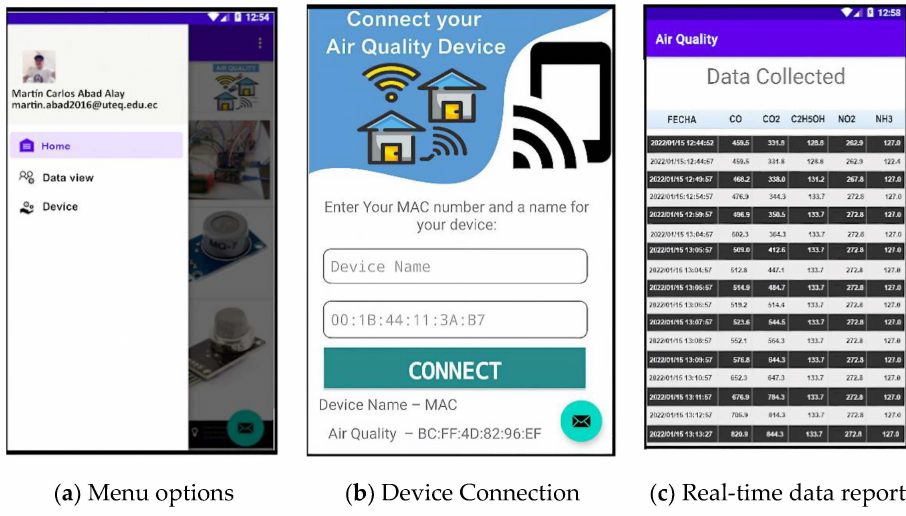
Figure 6. Screenshots of the mobile application.